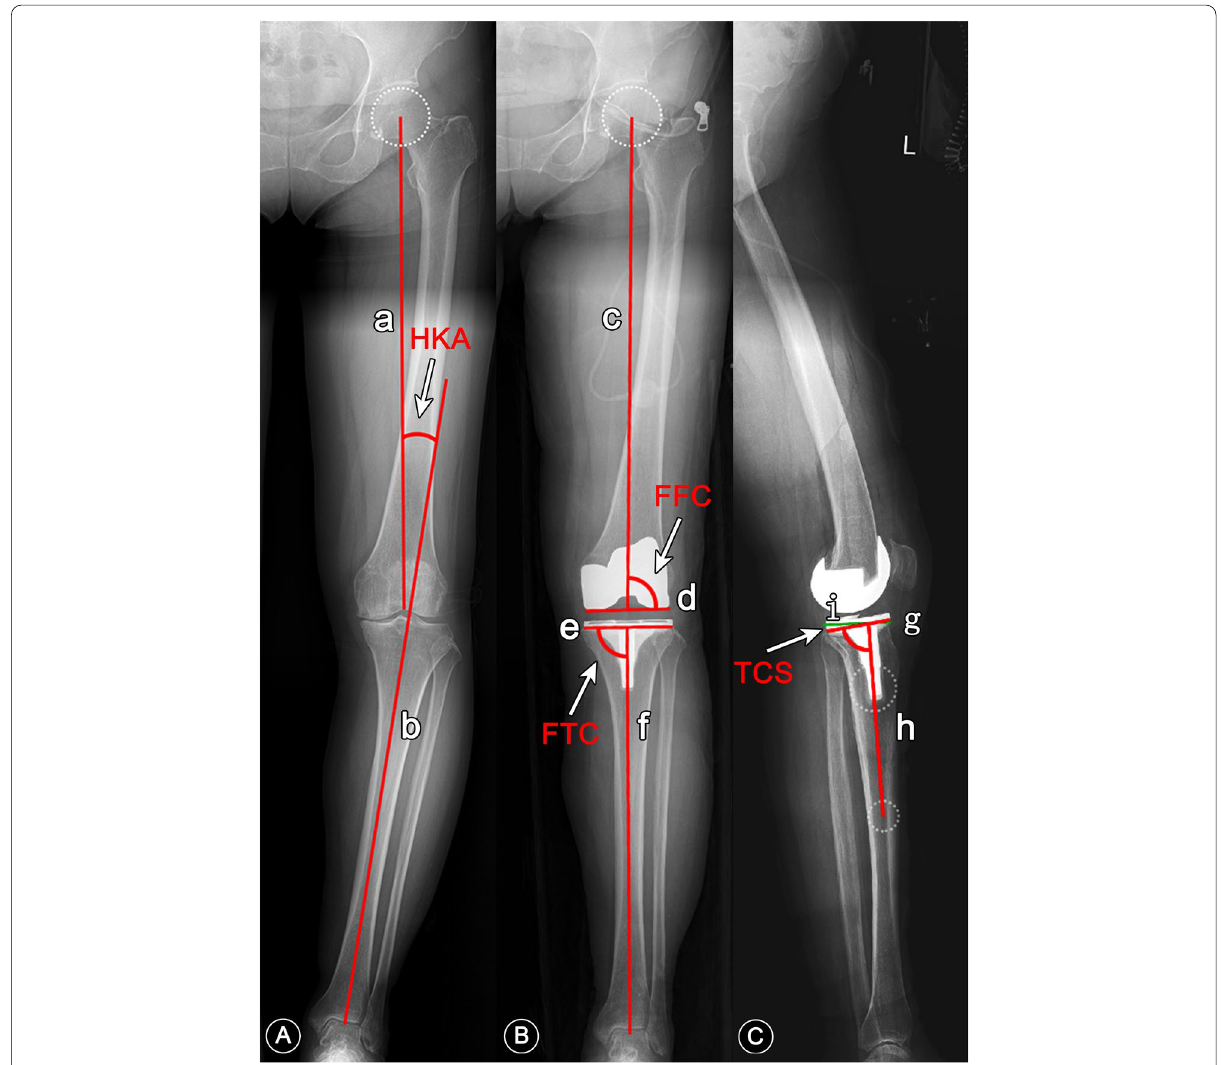
Fig. 2 Measurements of HKA angle, FFC, FTC and TCS. HKA: hip‑knee‑ankle; FFC: frontal femoral component angle; FTC: frontal tibial component angle; TCS: tibial component slope angle; A Preoperative HKA angle: the acute angle formed between the femoral mechanical axis (line a) and the tibial mechanical axis (line b). B Line c: postoperative femoral mechanical axis; line d: the line across the bottom of the femoral condyles; line e: the line across the bottom of the tibial plateau on the anteroposterior radiograph; line f: the postoperative tibial mechanical axis; FFC: the lateral angle between line c and line d; FTC: the medial angle between line e and line f; postoperative HKA angle: the acute angle between line c and line f. C Line g: the line across the bottom of the tibial plateau on the lateral radiograph; line h: the line connecting the center points of the tibial shaft 5 cm and 15 cm below the joint line; line i is perpendicular to line h; TCS: the acute angle between line i and line